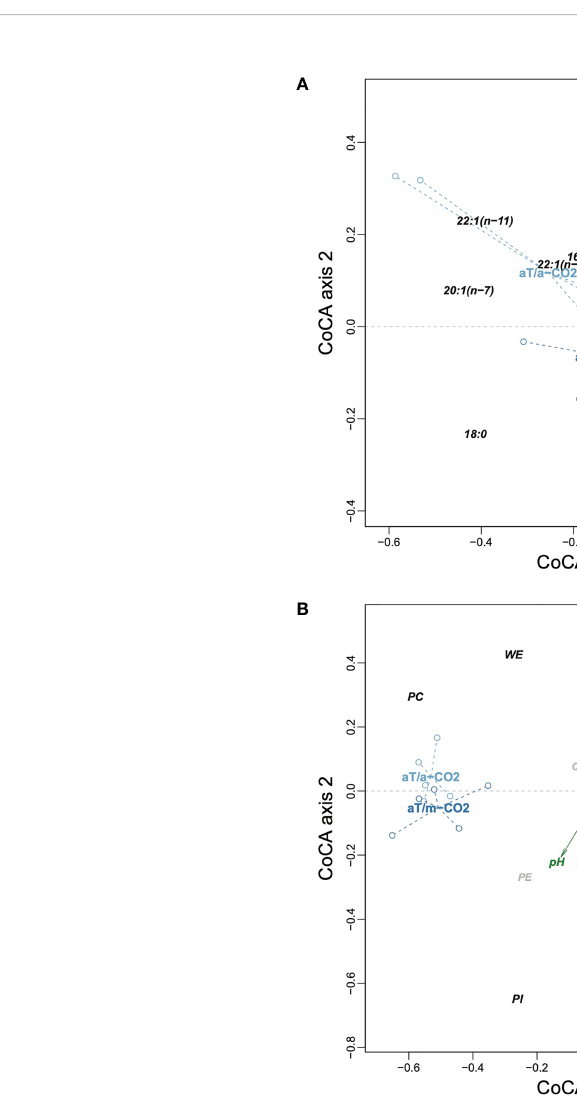
FIGURE 6 Co-correspondence analysis of fatty acid and lipid class compositions, showing (A) the fatty acids and (B) the lipid classes. In each case the variables that contribute more than average to the solution (i.e., the main drivers) are shown in dark italic and those less than average in light, smaller italic. Sample points are shown as empty circles connected by dashed lines to their respective group means, which are labeled. aT, ambient (= in situ ) temperature; hT, high temperature; a-CO 2 , ambient CO 2 ; m-CO 2 , medium CO 2 ; h-CO 2 , high CO 2